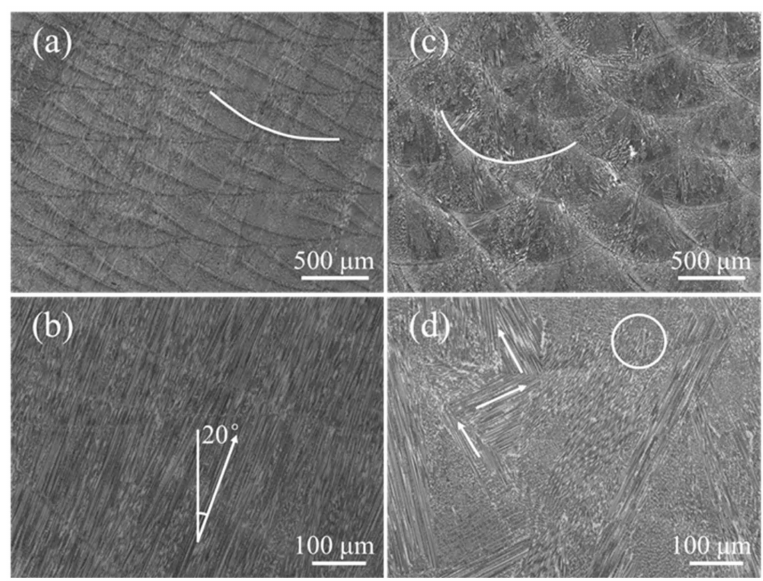
Figure 6. The microstructure with different pulse period: ( a , b ) 30 ms; ( c , d ) 100 ms.